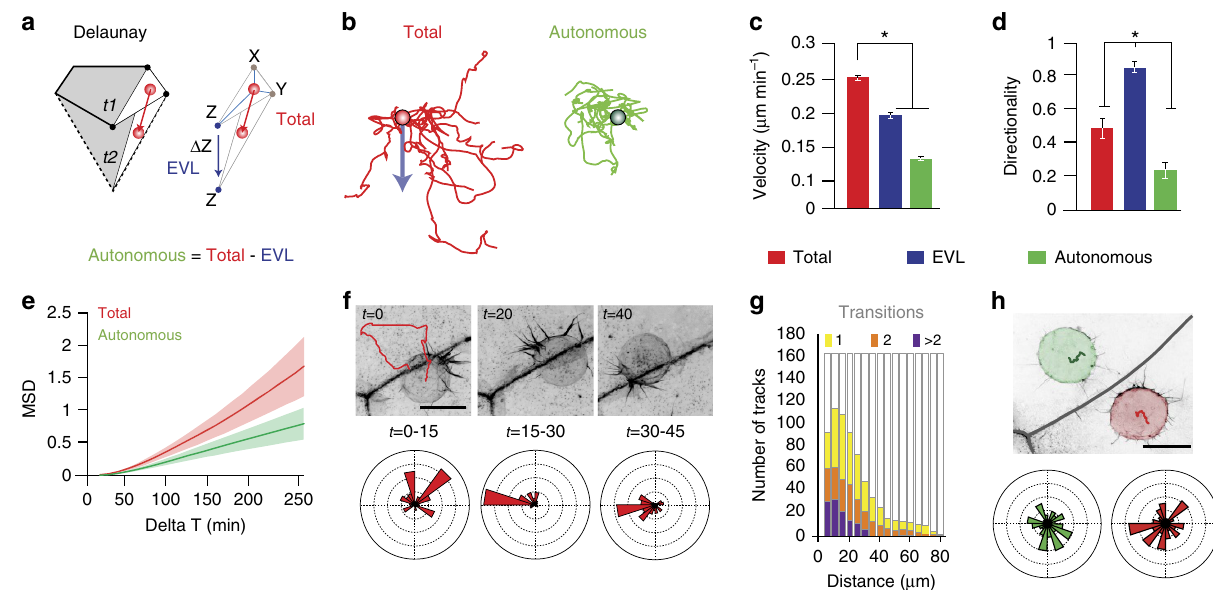
Figure 6 | Autonomous motility during spreading of the embryonic DCL. ( a ) Schematic diagram of the method used to estimate the autonomous movement of DCL cells (see Methods), by subtracting the movement of the EVL from the total DCL cell movement. ( b ) Examples of tracks for autonomous and total DCL cell movements, starting at a common point and aligned to the movement of EVL cells (blue arrow; n ¼ 8 tracks). ( c , d ) Quantification of the mean velocity ( c ) and directionality ( d , ratio of the distance between starting and ending points by the actual trajectory) of cell movement in the three depicted conditions. Values are expressed as means ± s.e.m. * P o 0.05 (Wilkoxon). ( e ) Quantification of the mean square displacement (MSD) for autonomous and total DCL cell movements, expressed as means ± s.e.m., as a measure of the area explored by cells for any given time interval. Plots from b – d correspond to 9 cells followed over a period of 18h (54 to 72 h.p.f.), extracted from Supplementary Movie 1. ( f – h ) DCL migratory behaviour at EVL cell borders. ( f ) Confocal microscopy z -stack maximum projections of an embryo expressing lifeact-GFP , showing a single DCL cell moving around the EVL cell border during a period of 45min. The red line corresponds to the track followed by the cell barycentre. Circular plots depict the orientation of filopodial-like membrane protrusions during three consecutive 15-min periods (from Supplementary Movie 3). ( g ) Distribution of the number of tracks of DCL movement that crossed defined boundary regions at growing distances from EVL cell borders, as a measure to define the preferential region of DCL migration. Different colours depict different number of transitions (from Supplementary Movie 1). ( h ) In embryos expressing lifeact-GFP and overexpressing Rac1-T17N, DCL cells barely move at EVL cell borders (Supplementary Movie 4). Red and green lines depict the tracks followed by cells during a period of 20min. Circular plots depict the orientation of thin filopodial-like membrane protrusions of the two DCL cells. Scale bar, 30 m m ( f